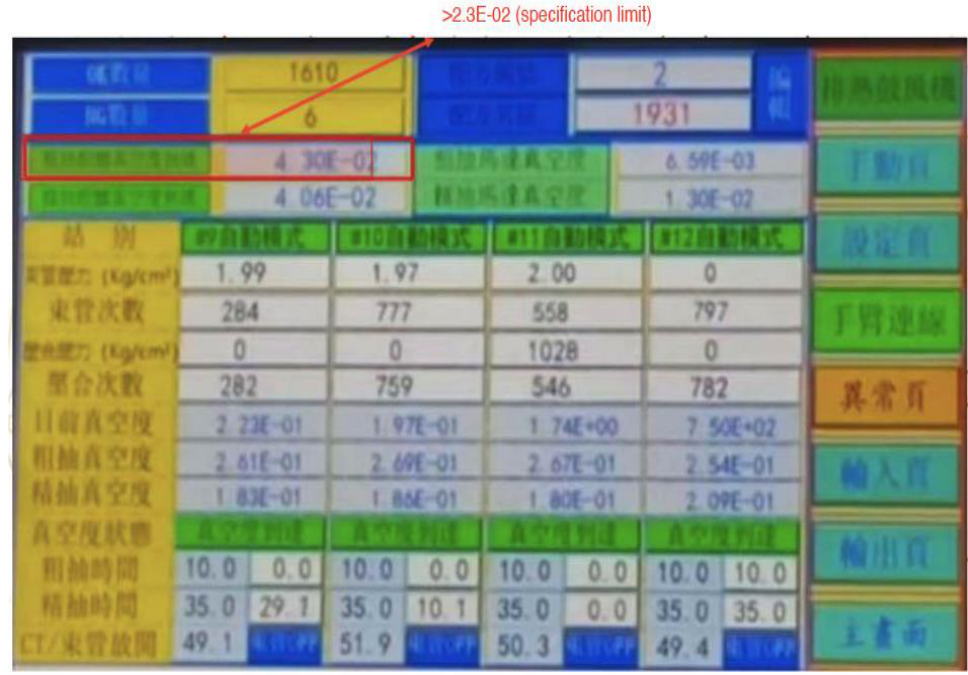
Figure 8. Sensor connected with internet of things technology on the machine interface.